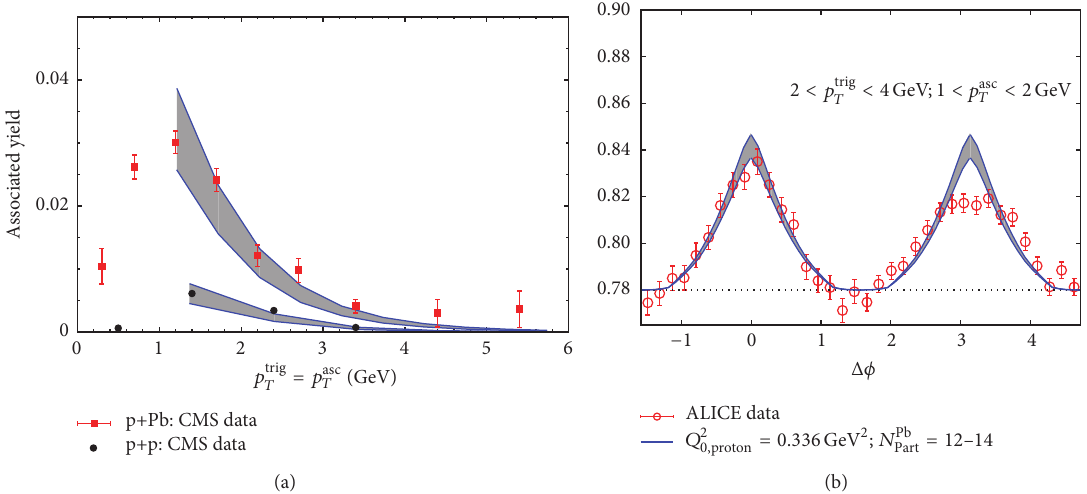
Figure 8: Figure showing the systematics of ridge-like correlations in p+p and p+Pb collisions captured in the Glasma graph framework taken from [31]. The comparisons are made with the CMS data for p+p and p+Pb collisions for events having 𝑁 offline ALICE data for p+Pb collisions [7].